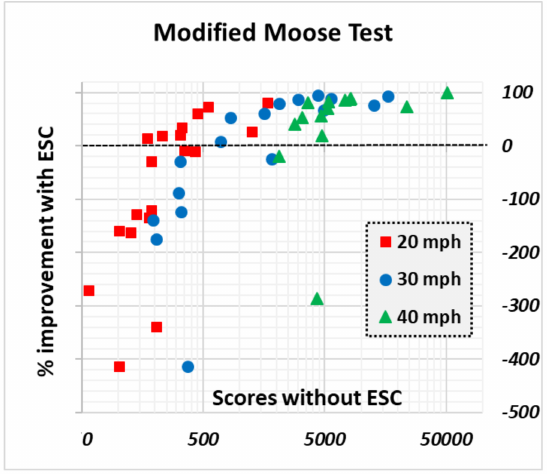
Figure 22. Percent improvement with ESC (modified Moose